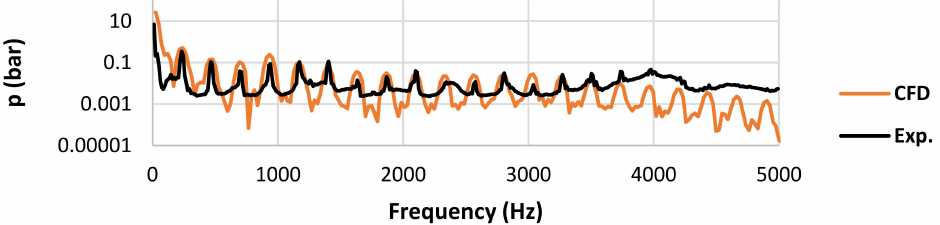
Figure 23. Delivery port pressure ripple FFT analysis obtained from the CFD simulations and the experiment for the TMC at p 2 = 22.5 bar pressure load, 20 ◦ C oil temperature and 2000 rpm.